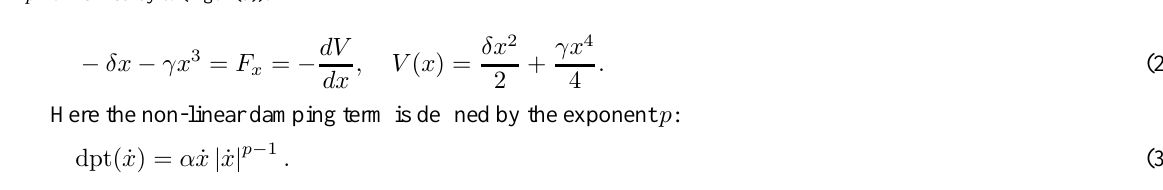
Fig. 1. External potential V ( x ) for δ = − 1 and γ = 1 (Fig. 1(a)); and velocity ( v = ˙ x ) dependence of a damping term dpt( ˙ x ) /α for different p normalized by α (Fig.